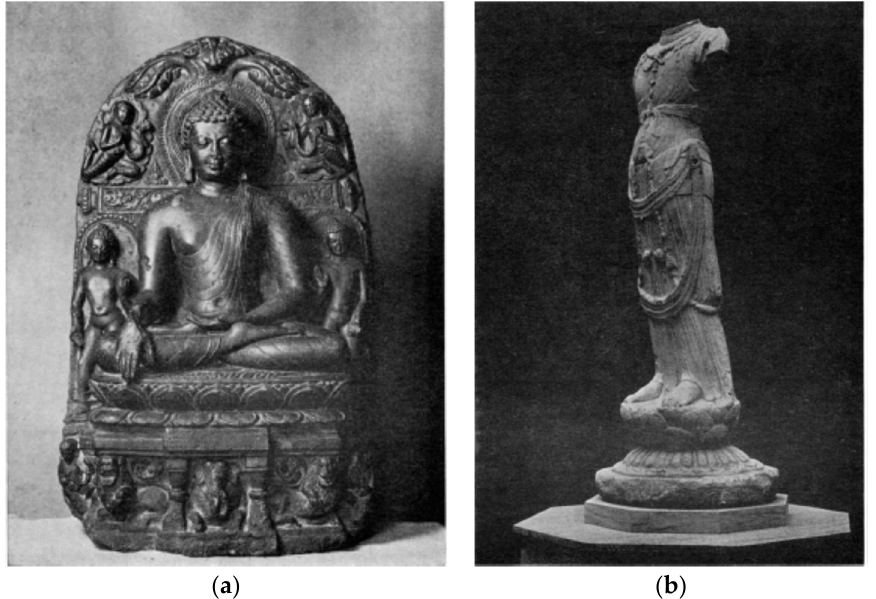
Figure 3. The original images of the lotus pedestals. ( a ) Buddha statue, Indian, Pala Period; ( b ) Kuan Yin statue, Chinese, Sui or Early Tang Dynasty (Images are as part of the Metropolitan Museum of Art’s Open Access policy).